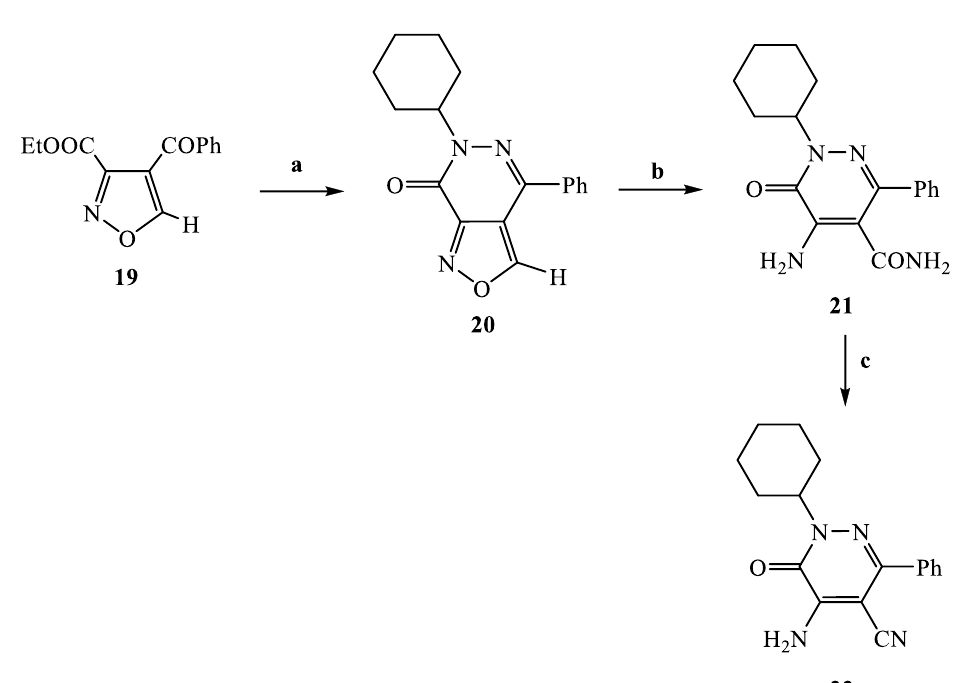
Scheme 3. Reagents and conditions: ( a ) cyclohexylhydrazine, PPA, EtOH, 70 °C, 30 min; ( b ) 33%